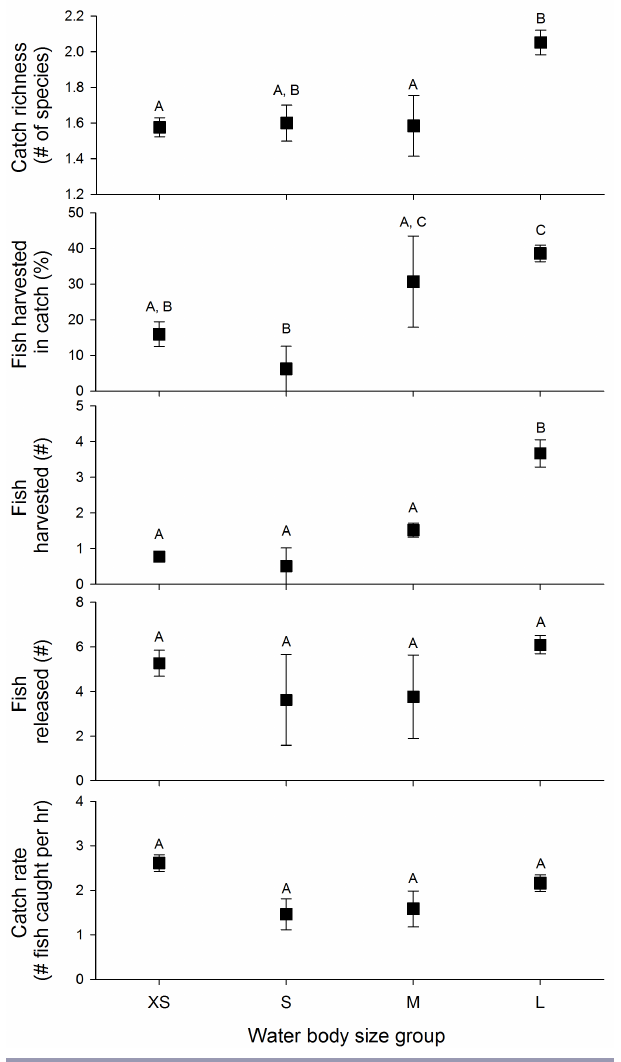
Fig. 3 . Catch attribute differences (± SE) among water body groups (XS = extra small, S = small, M = medium, L = large) for catch richness, fish harvested in catch, fish harvested, fish released, and catch rate. Different letters indicate significant differences among water body groups for each attribute as indicated by separate univariate ANOVA’s and post-hoc Tukey HSD tests (conversely same letters = no significant difference).